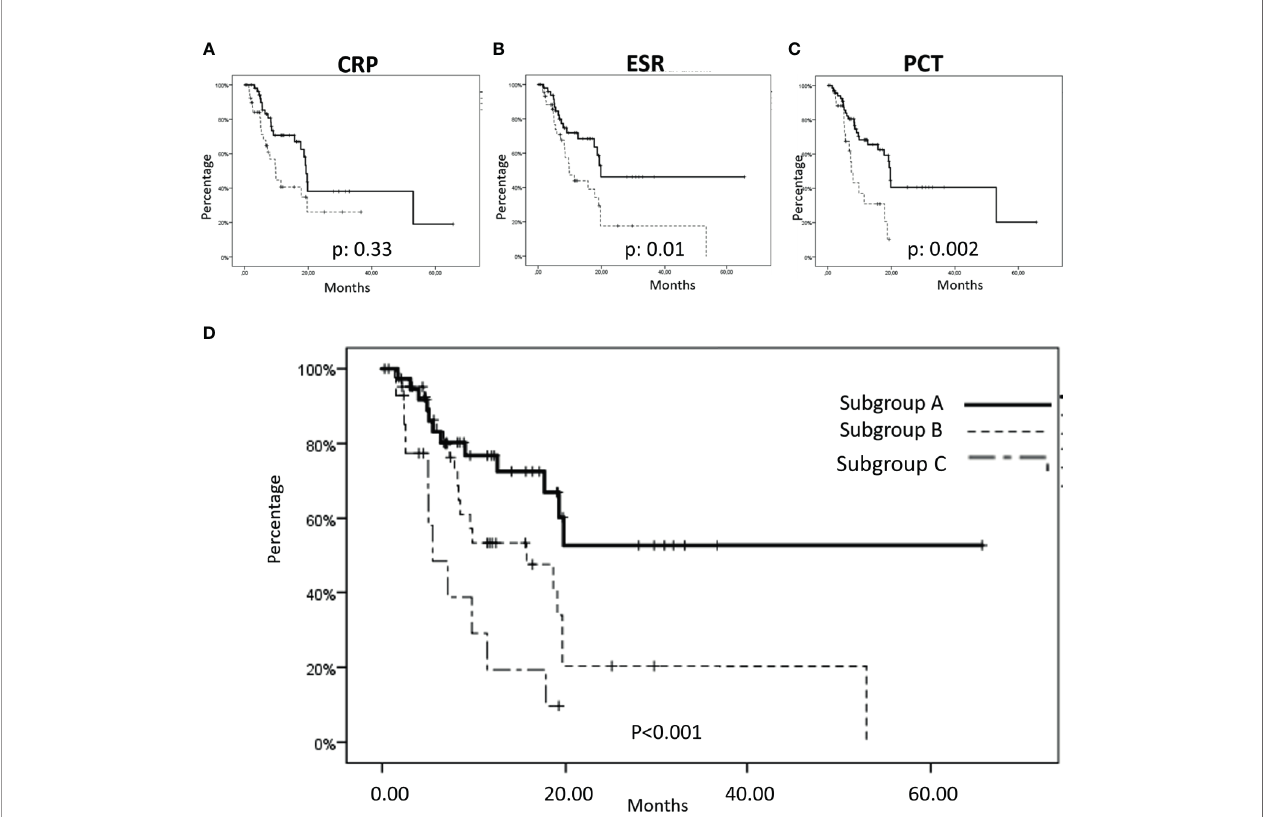
FIGURE 2 | Overall survival (OS) considering in fl ammation status markers in metastatic non-small cell lung cancer (mNSCLC) patients. (A – C) In our series, we found a signi fi cant cut-off of the baseline expression of CRP, ESR and PCT that was strongly correlated to a worse outcome in terms of OS; (A) Speci fi cally, patients with a CRP ≤ 16 showed a median OS of 19.3 ± 0.6 months, mean: 30.5 ± 4.7 months, versus a median OS of 9.7 ± 1.4 months, mean: 15.9 ± 27 months in patients with a CRP >16, with a p-value of 0.033; (B) Patients with ESR ≤ 40 showed a median OS of 19.8 ± 1.5 months, mean: 36.5 ± 5.4 months, versus a median OS of 9.8 ± 1.9 months, mean: 17.7 ± 3.5 months in patients with an ESR >40, with a p-value of 0.01; (C) Finally, patients with a PCT ≤ 0.1 showed a median OS of 19.6 ± 0.4 months, mean: 31.0 ± 4.3 months, versus a median OS of 7.3 ± 0.6 months, mean: 10.1 ± 1.4 months, in patients with a PCT >0.10, with a p-value of